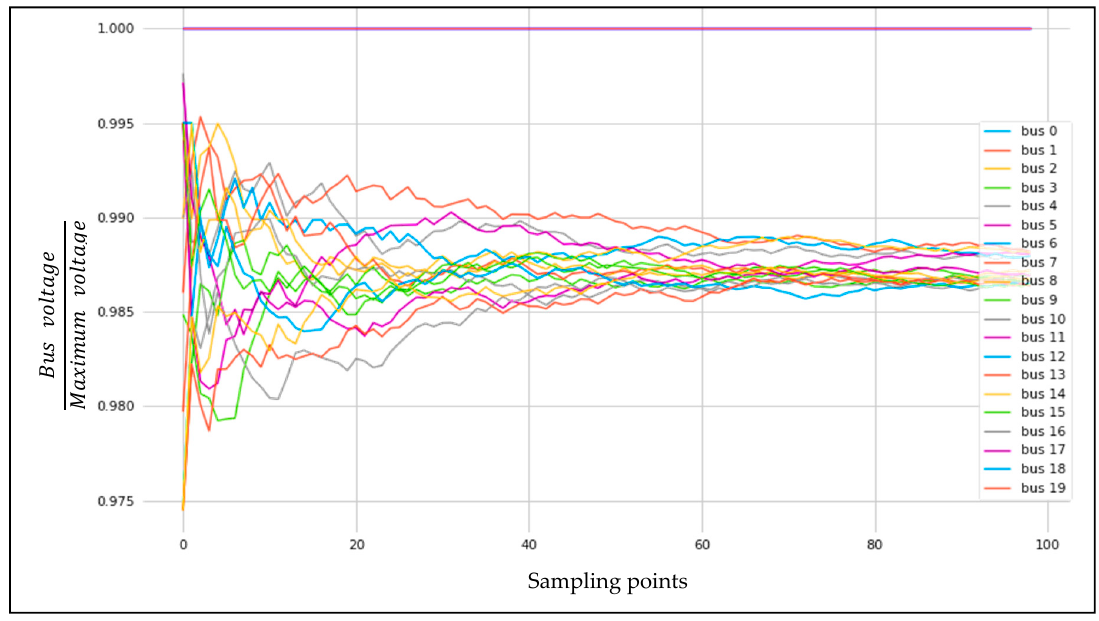
Figure 14. Latin hypercube RTO load average for NASA N3-X.